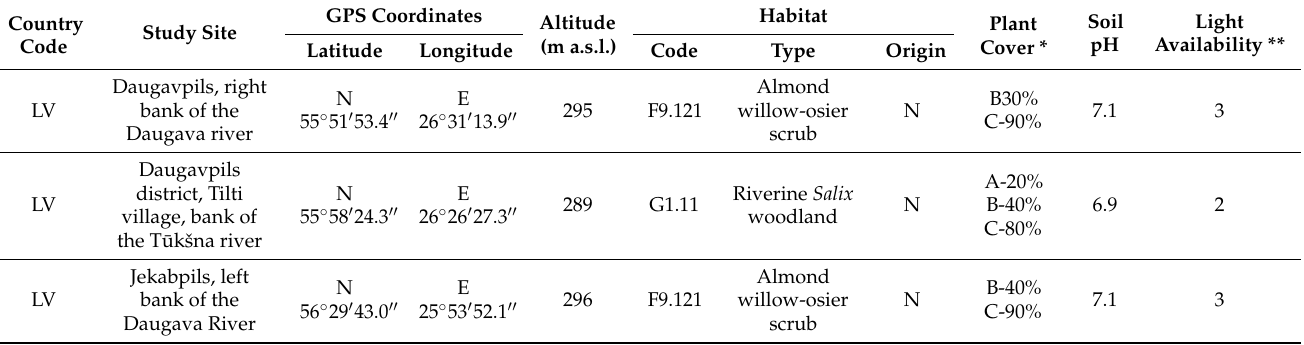
Table A1. Characteristics of study sites located in Latvia (LV), Lithuania (LT), Poland (PL), and Slovakia